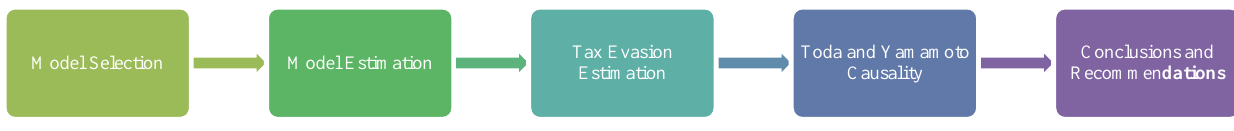
Figure 1. Flowchart of the research